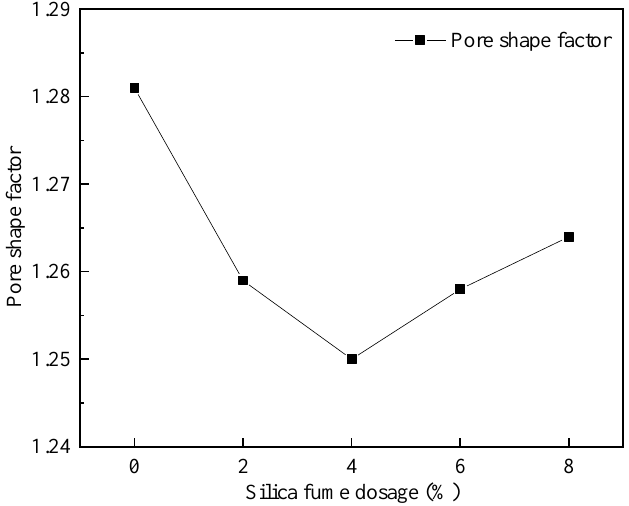
Figure 19. Effect of silica fume dosage on pore shape factor.